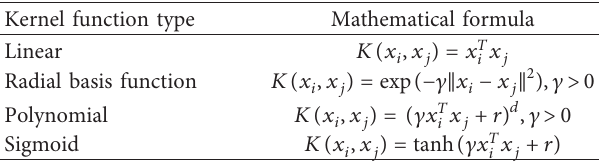
Table 1: Four kernel functions and formulas. Kernel function type Mathematical